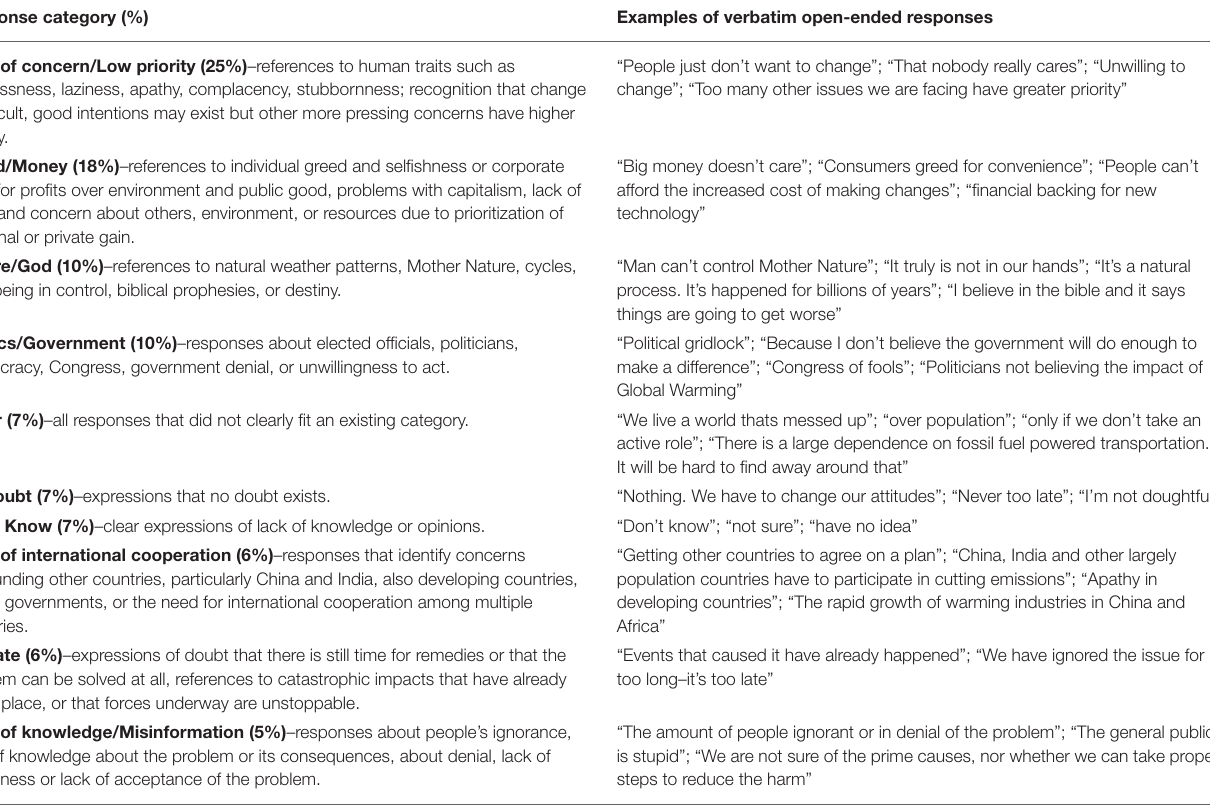
TABLE 3 | Open-ended responses about what is making Americans doubtful about climate change. Response category